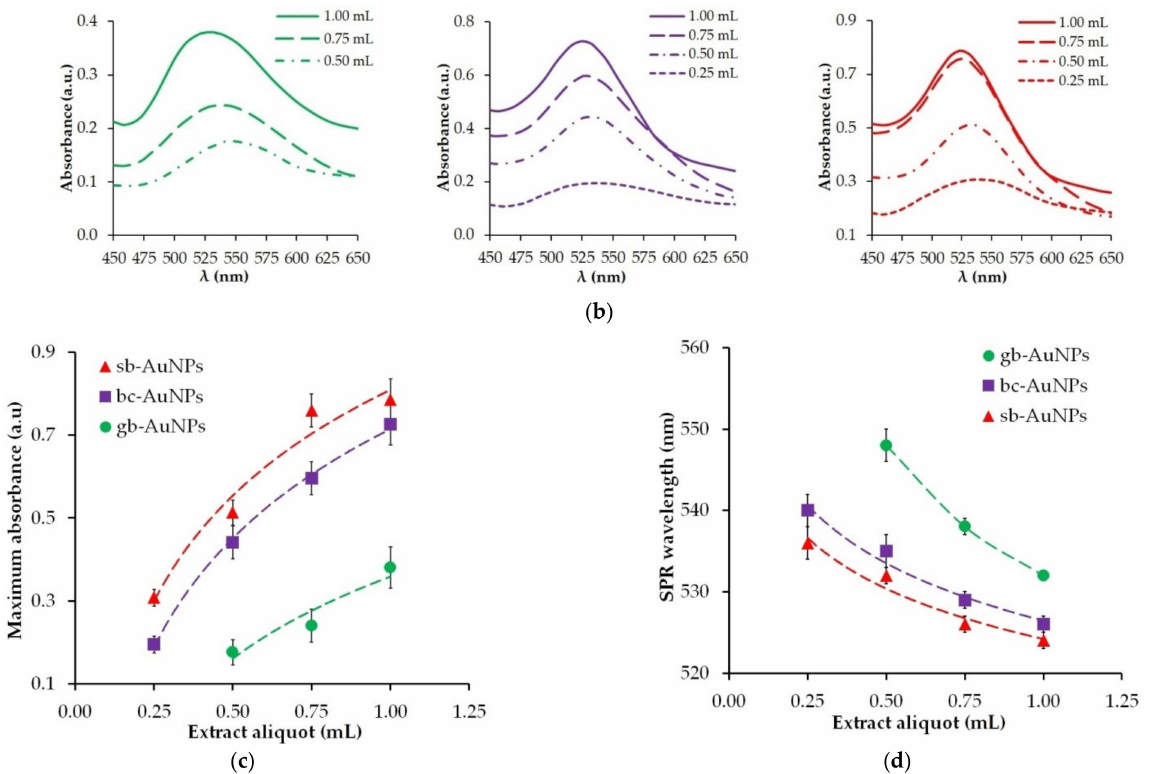
Figure 1. Images of gold sols synthesized with plant extract aliquots ( a ) and corresponding UV–vis spectra ( b ). The impact of extract aliquot (pH 6) on maximum absorbance ( c ) and the position of the characteristic SPR band ( d ) of